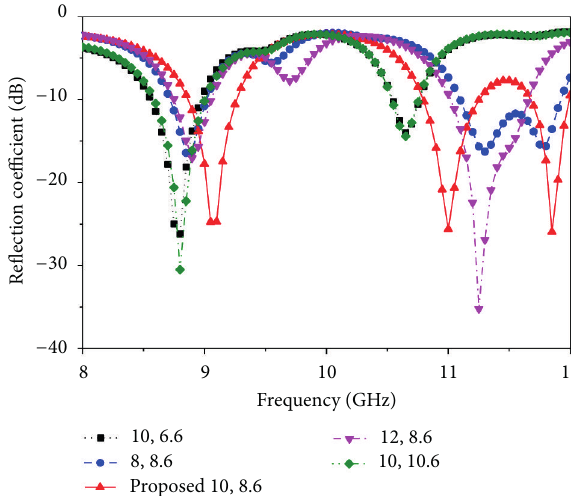
= 9 mm, 𝑊 = 4 mm, 𝐿 = 20 mm, 𝑠 𝑠 𝑔 𝑌 = 10, 8.6 𝑓 , 𝑓